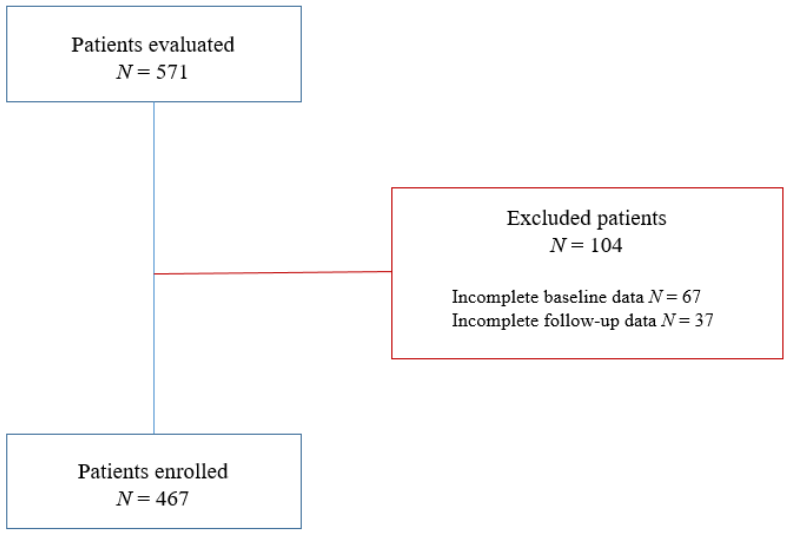
Figure 1. Inclusion graph of the study population.